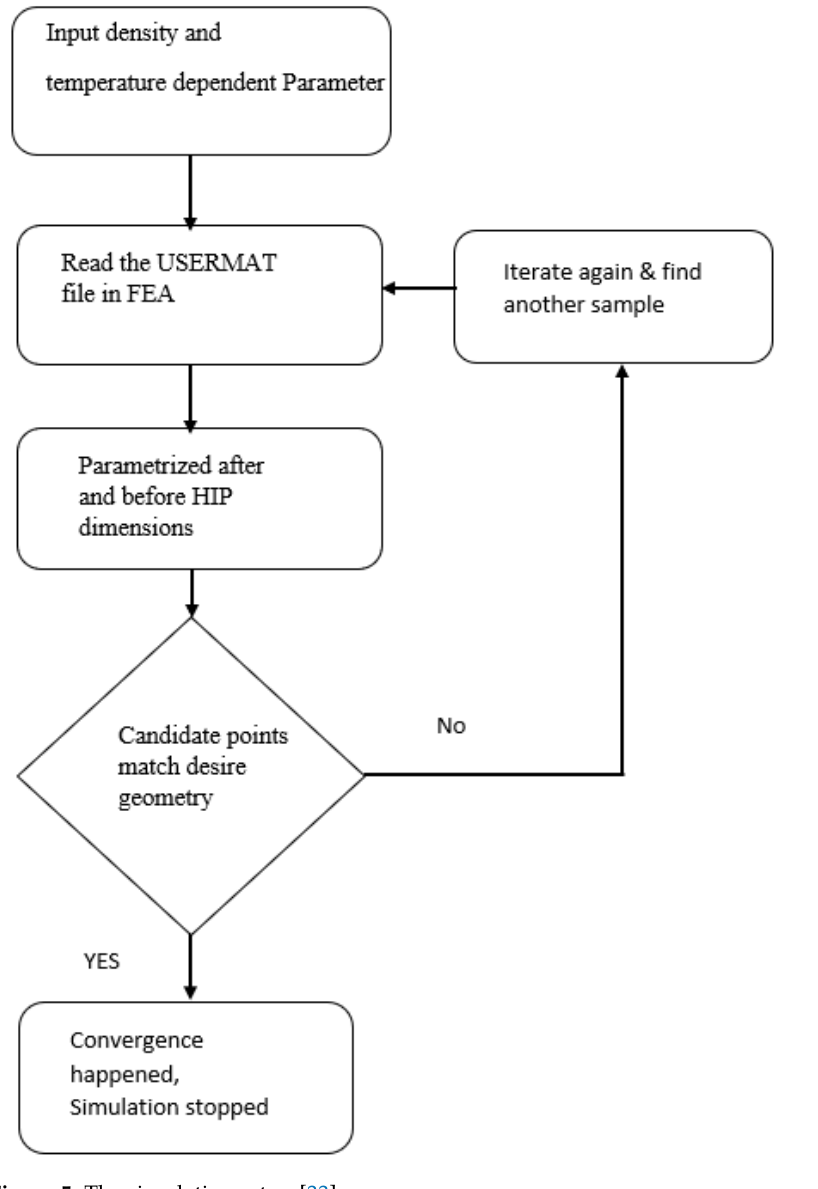
Figure 5. The simulation setup [33]. Table 1. The material properties